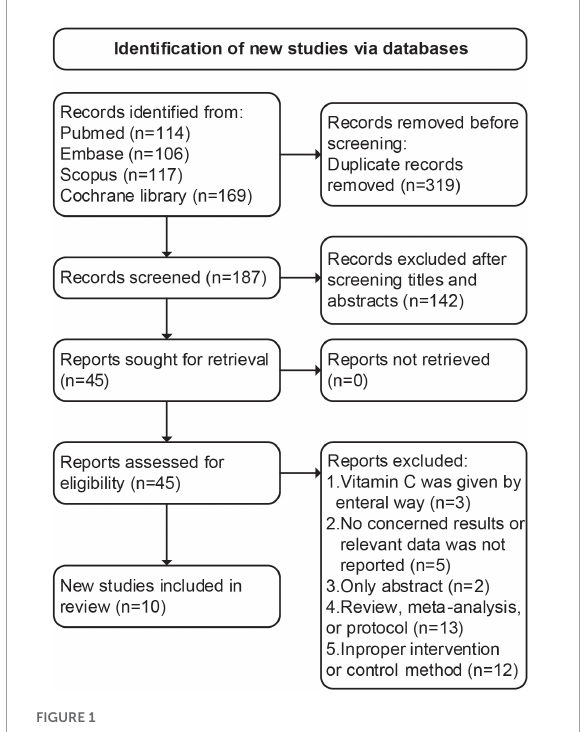
FIGURE1 PRISMA 2020 flow diagram for the